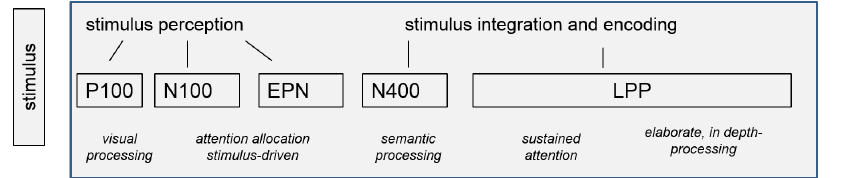
Figure 2. Temporal processing in the EEG as exemplified by the modulation of event-related brain potentials (ERPs).